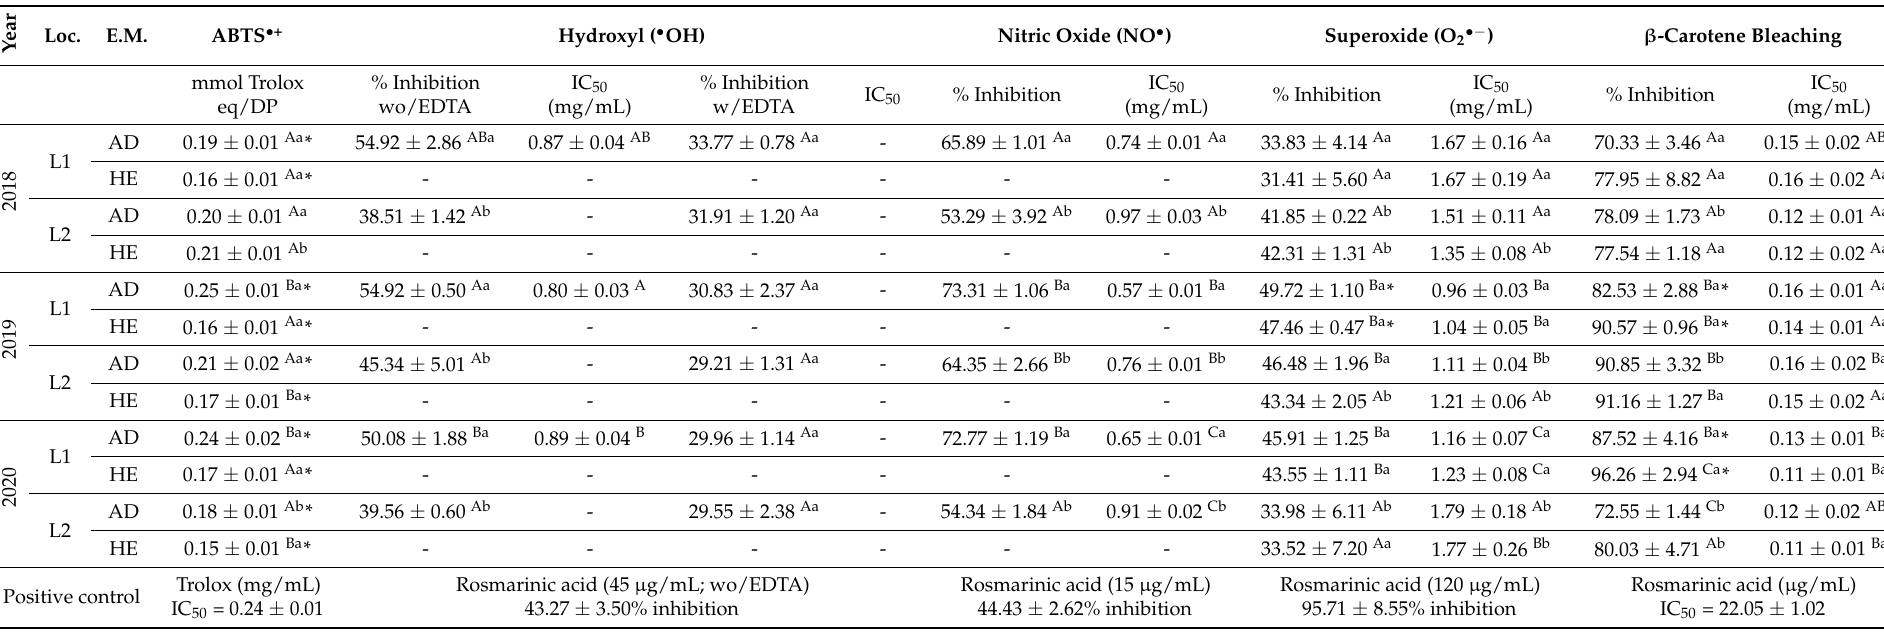
Abbreviations: AD: aqueous decoction and HE: hydroethanolic extractions; Loc.: location; E.M.: extraction method; Tukey’s post hoc test was performed to analyze significant statistical differences between extraction methods (*), between harvest years for the same location (different capital letters), and between locations for the same year (different lowercase letters)